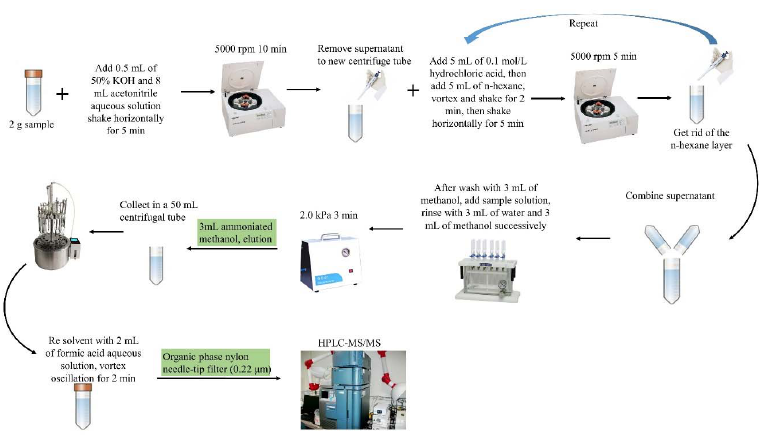
Figure 1. Schematic diagram of sample